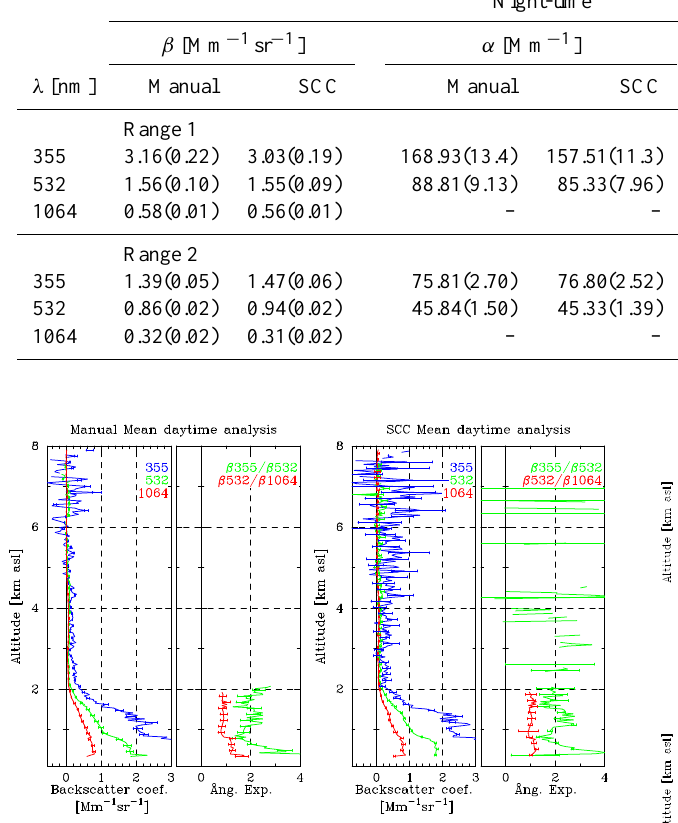
Figure 13. Mean daytime analysis comparison for the Leipzig sta- tion (Polly XT system). On the left the mean analysis obtained using the manual analysis is shown, while on the right the results obtained by the SCC are presented. Several measurement cases (see Table 2) have been analysed, and the corresponding backscatter profiles have been averaged (left two panels of each graph). The other panel of each graph shows the backscatter related Ångström exponents as calculated from the mean backscatter profiles.